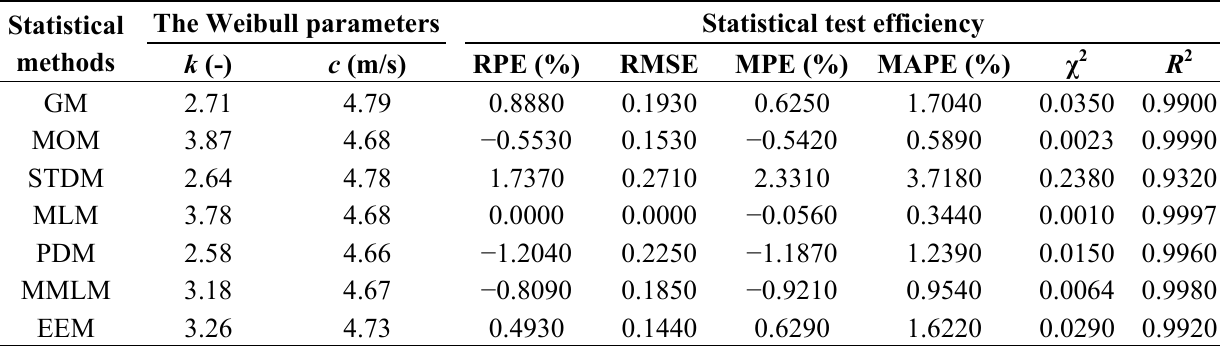
Table 5. The Weibull distribution analysis for Station-I at 30 m